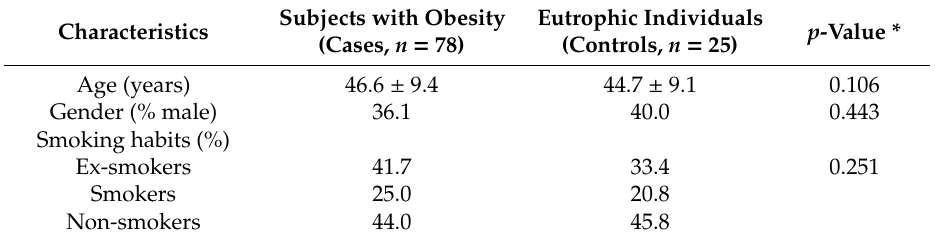
Table 1. Clinical, dietary and laboratory characteristics of the sample included in the